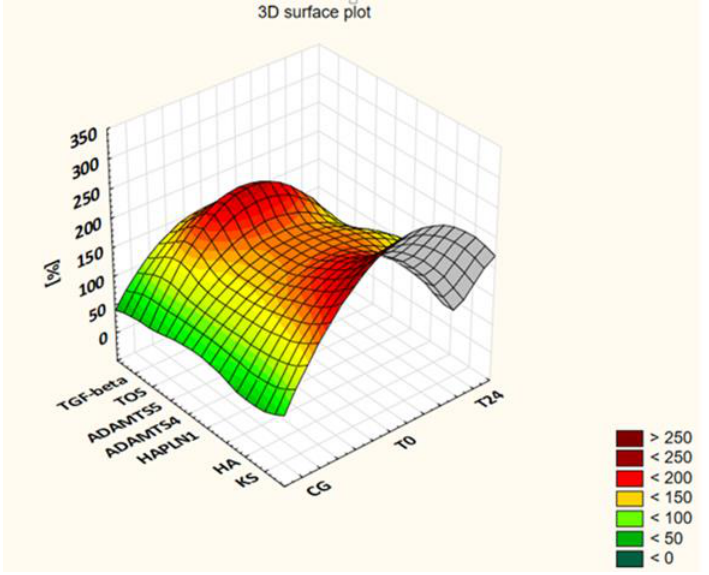
Figure 1. The changes in KS, HA, HAPLN1, ADAMTS4, ADAMTS5, TOS and TGF- β levels in JIA patients during ETA therapy as a percentage of the control group (CG) value.